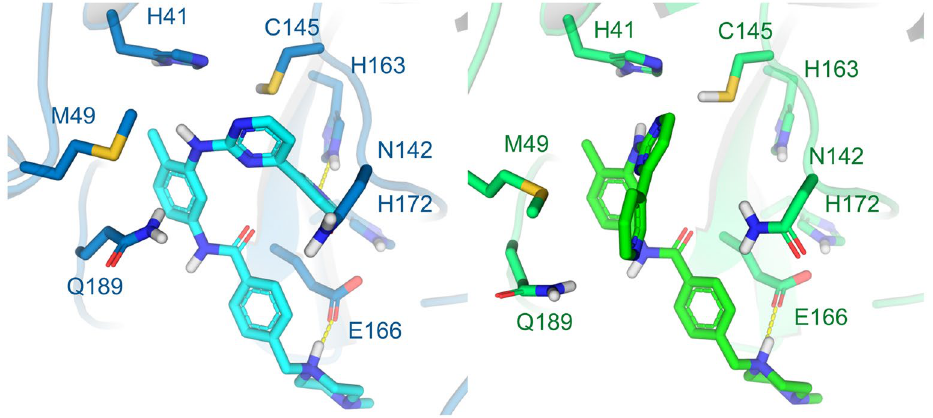
Figure 8. Predicted binding modes of imatinib against the Mpro conformations 6LU7 (left, score = − 10.09 kcal/ mol, imatinib represented as cyan sticks) and 6W63 (right, score = − 8.80 kcal/mol, imatinib represented as green sticks). Hydrogen bonds are represented as yellow dashed